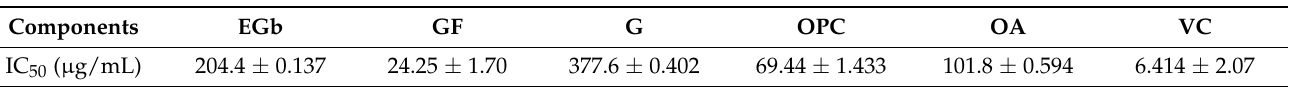
Table 4. Synergistic effect of functional components of EGb scavenging ABTS free radical.